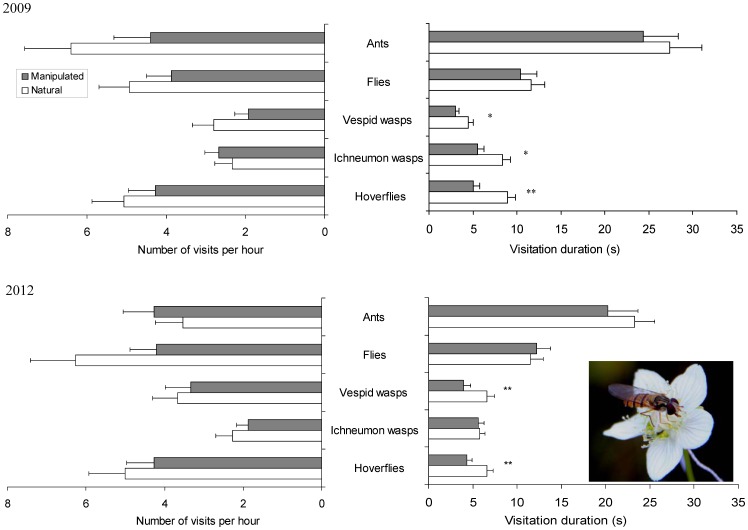
Visitation rate and duration of floral visitors to natural and manipulated flowers in two years.Data are Mean ± SE (“*” P<0.025; “**” P<0.005; one-way ANOVA). The inserted picture shows the most common pollinator, a hoverfly, visiting a manipulated flower.